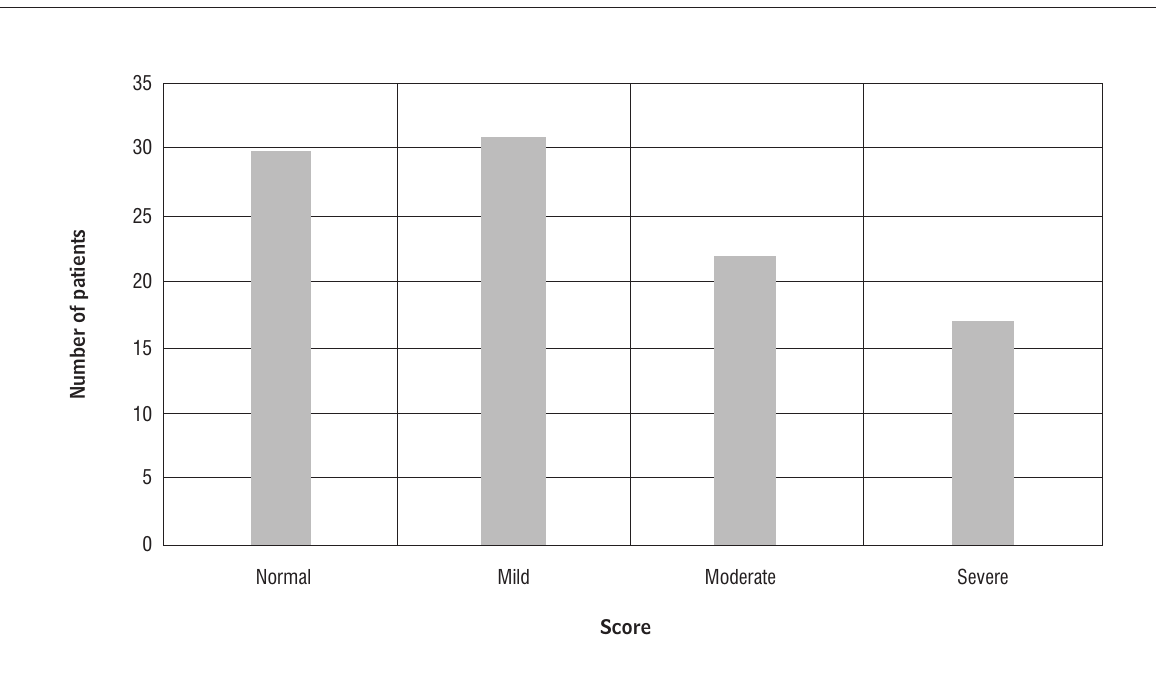
Figure 2 - Epworth Sleepiness Scale (ESS)